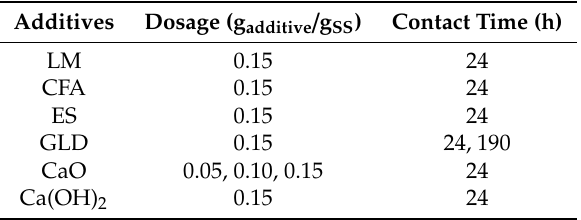
Table 2. Chemical sanitation